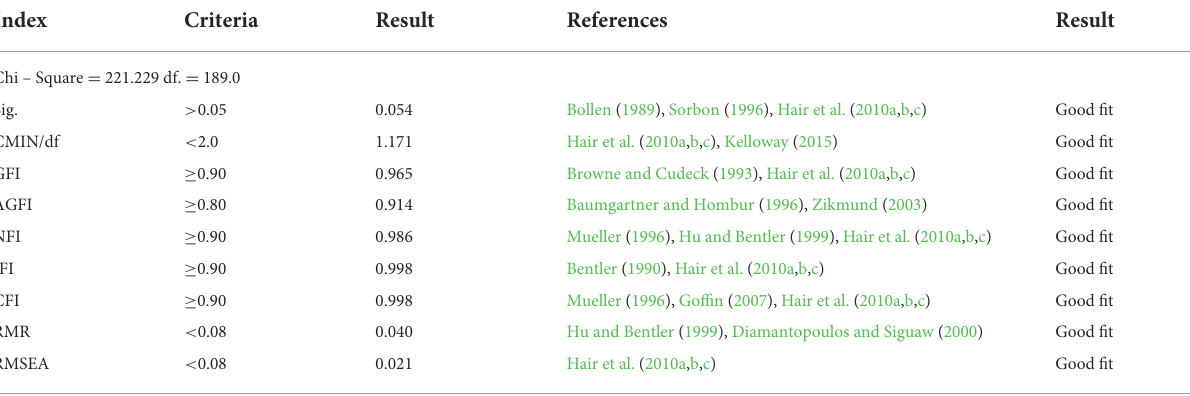
TABLE 6 Fit indices proposed for the model of risk knowledge pathways to behavioral intention of air travel risk perception during COVID-19.